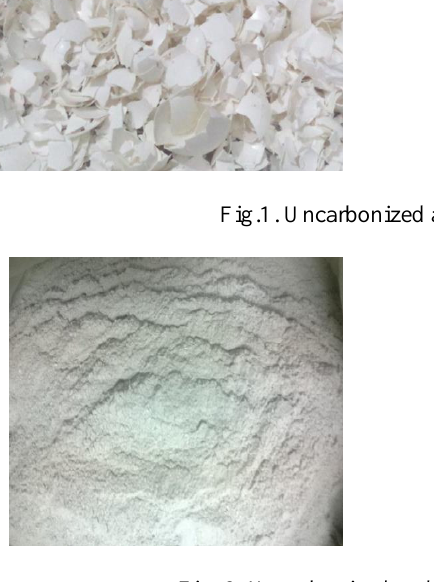
Fig. 2. Uncarbonized and carbonized egg shell